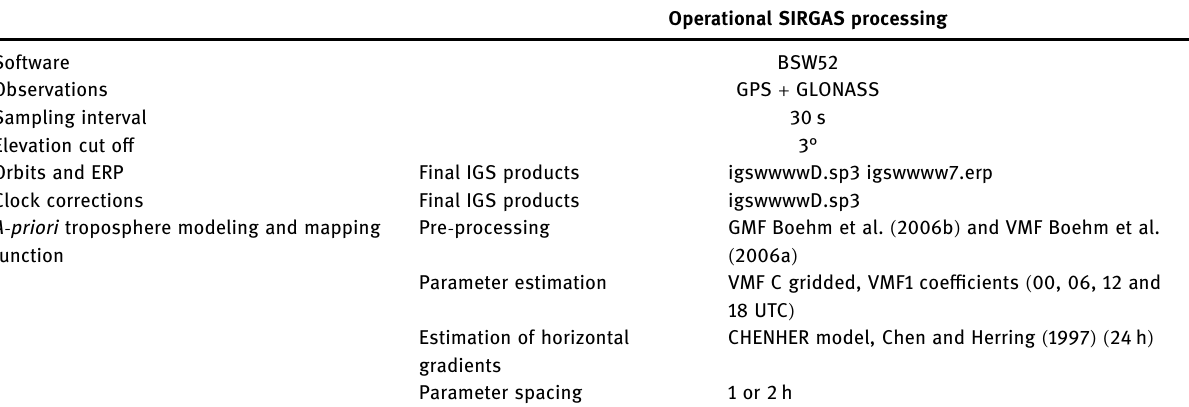
Table 1: Operational SIRGAS processing parameters ( Mackern et al. 2020 )